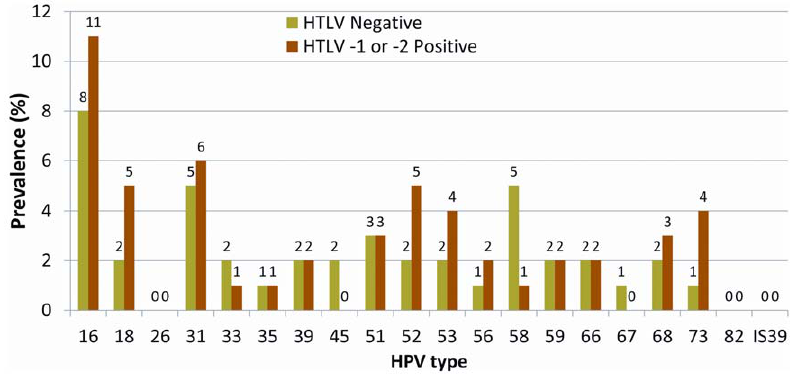
Figure 1. Prevalence of high-risk HPV among Shipibo-Konibo women with and without HTLV-1 or 2 infections. doi:10.1371/journal.pone.0044240.g001 PLOS ONE |